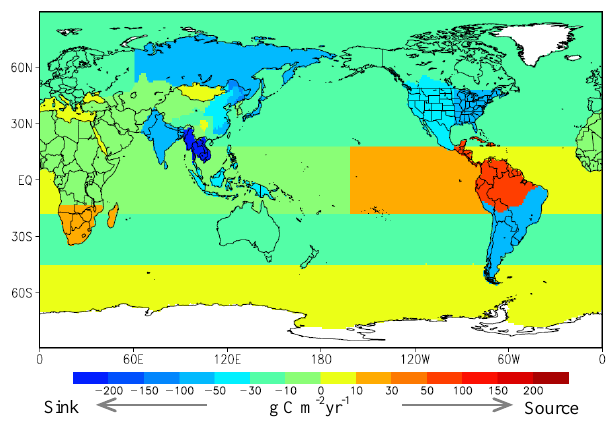
Fig. 3. Inverted mean distribution of terrestrial and ocean carbon fluxes (averaged for 2002–2008).